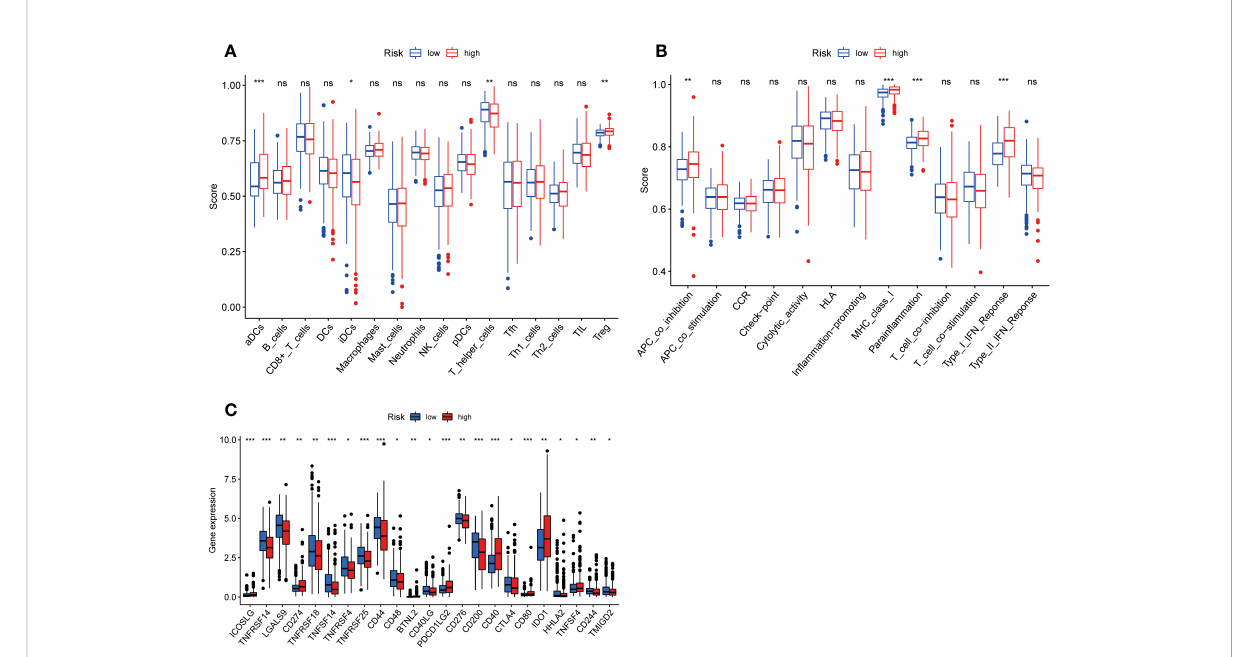
FIGURE 6 Figure 6 Immune in fi ltrating cell scores, immune-related functions, and immune checkpoint gene pro fi les in high-risk and low-risk populations. (A) Differences in in fi ltration of 16 immune cells between highrisk and low-risk groups were calculated using the ssGSEA algorithm. (B) Correlations of 13 immune-related functions with predictive signature in high- and low-risk populations. (C) Expression of immune checkpoint genes in high-risk and low-risk populations. ssGSEA, single sample gene set enrichment analysis; aDCs, activated dendritic cells; iDCs, immature dendritic cells; NK, natural killer; pDCs, plasmacytoid dendritic cells; Tfh, T follicularhelper; Th1, T helper type 1; Th2, T helper type 2; TIL, tumor-in fi ltrating lymphocyte; Treg, T regulatory cell; APC, antigen-presenting cell; CCR, chemokine receptor; HLA, human leukocyte antigen; MHC, major histocompatibility complex. *p < 0.05; **p < 0.01; ***p < 0.001; ns, non-signi fi